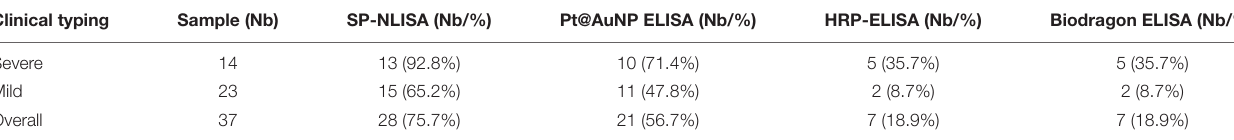
TABLE 1 | Sensitivity of SP-NLISA and control assays for testing of NP antigens in serums from COVID-19 patients. Clinical